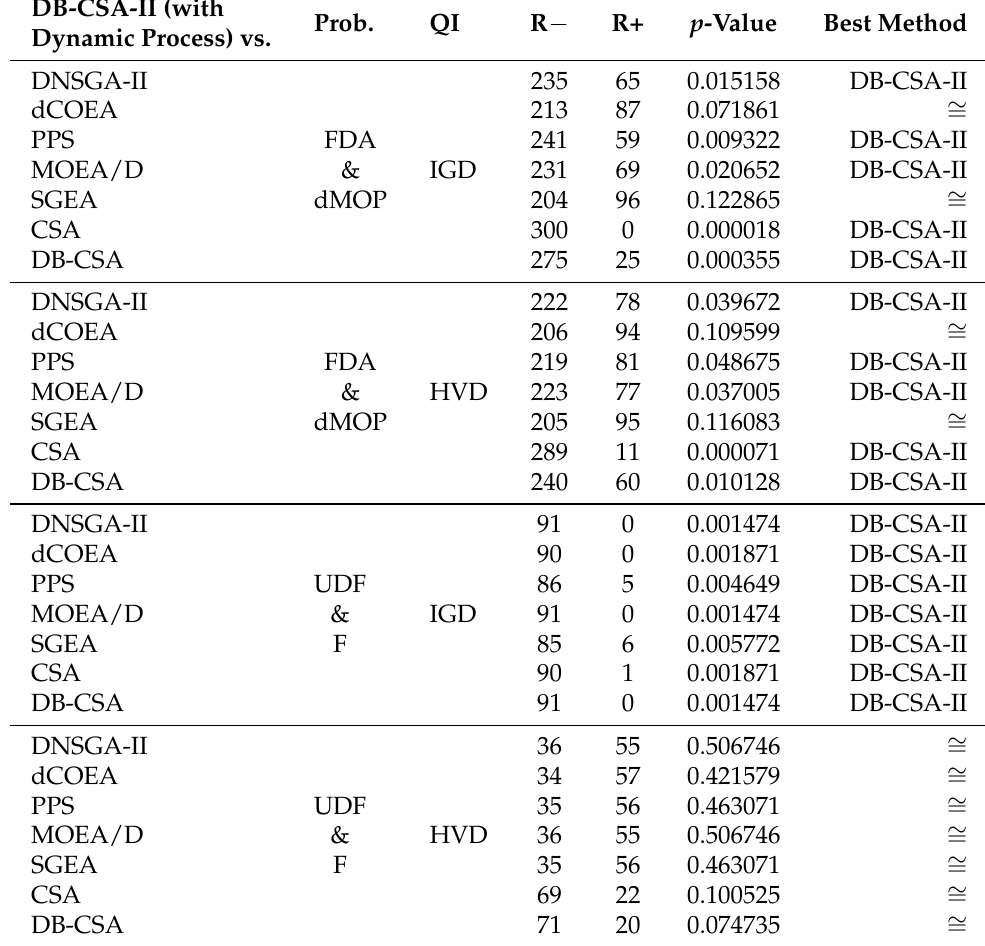
Table 9. Non-parametric statistical analysis based on a Wilcoxon signed rank test of DB-CSA-II vs. five peer MOEAs over IGD, HVD metrics for FDA, dMOP, UDF and F functions. DB-CSA-II (with